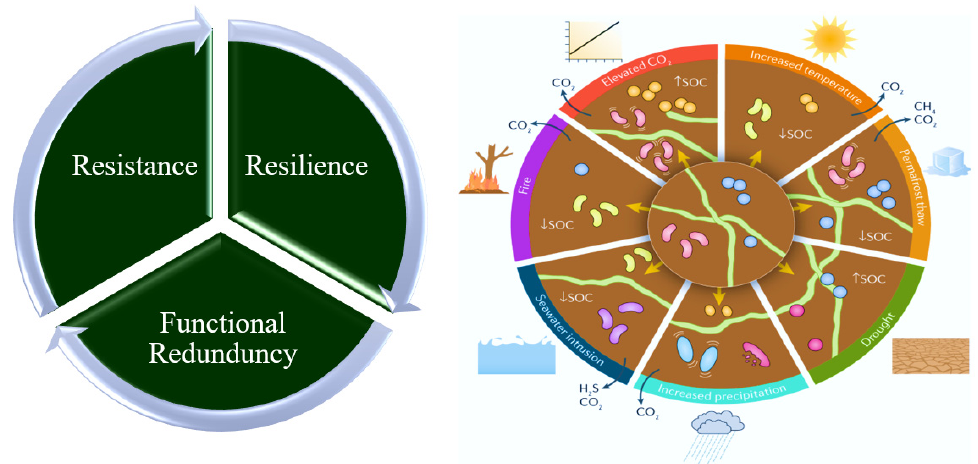
Figure 1. Soil Microbial Responses to Changing climate.